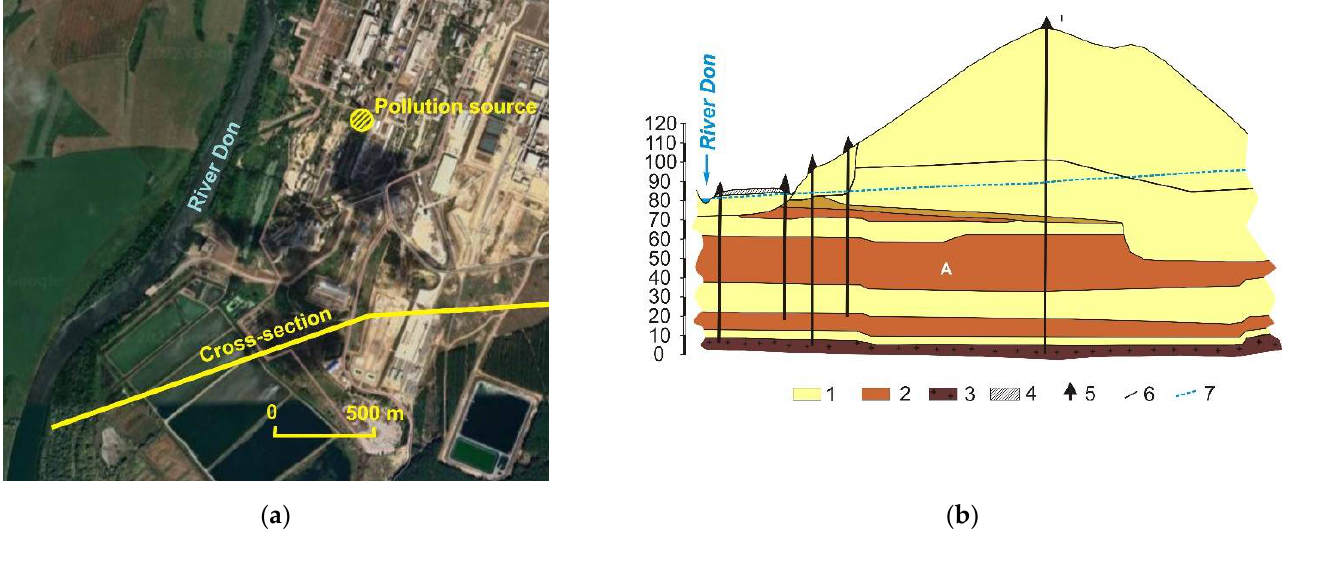
Figure 4. Pollution site at the APP Novovoronezhskaya. ( a ) Location of the pollution site (from Google satellite photograph). ( b ) Vertical cross-section of the pollution site (after data from enterprise “Gydrospetsgeologiya”). (1) highly permeable sedimentary deposits; (2) low-permeability clayey rocks; (3) tight basement rocks; (4) Quaternary deposits; (5) exploratory boreholes; (6) boundaries between sedimentary deposits of different origin; (7) water table.